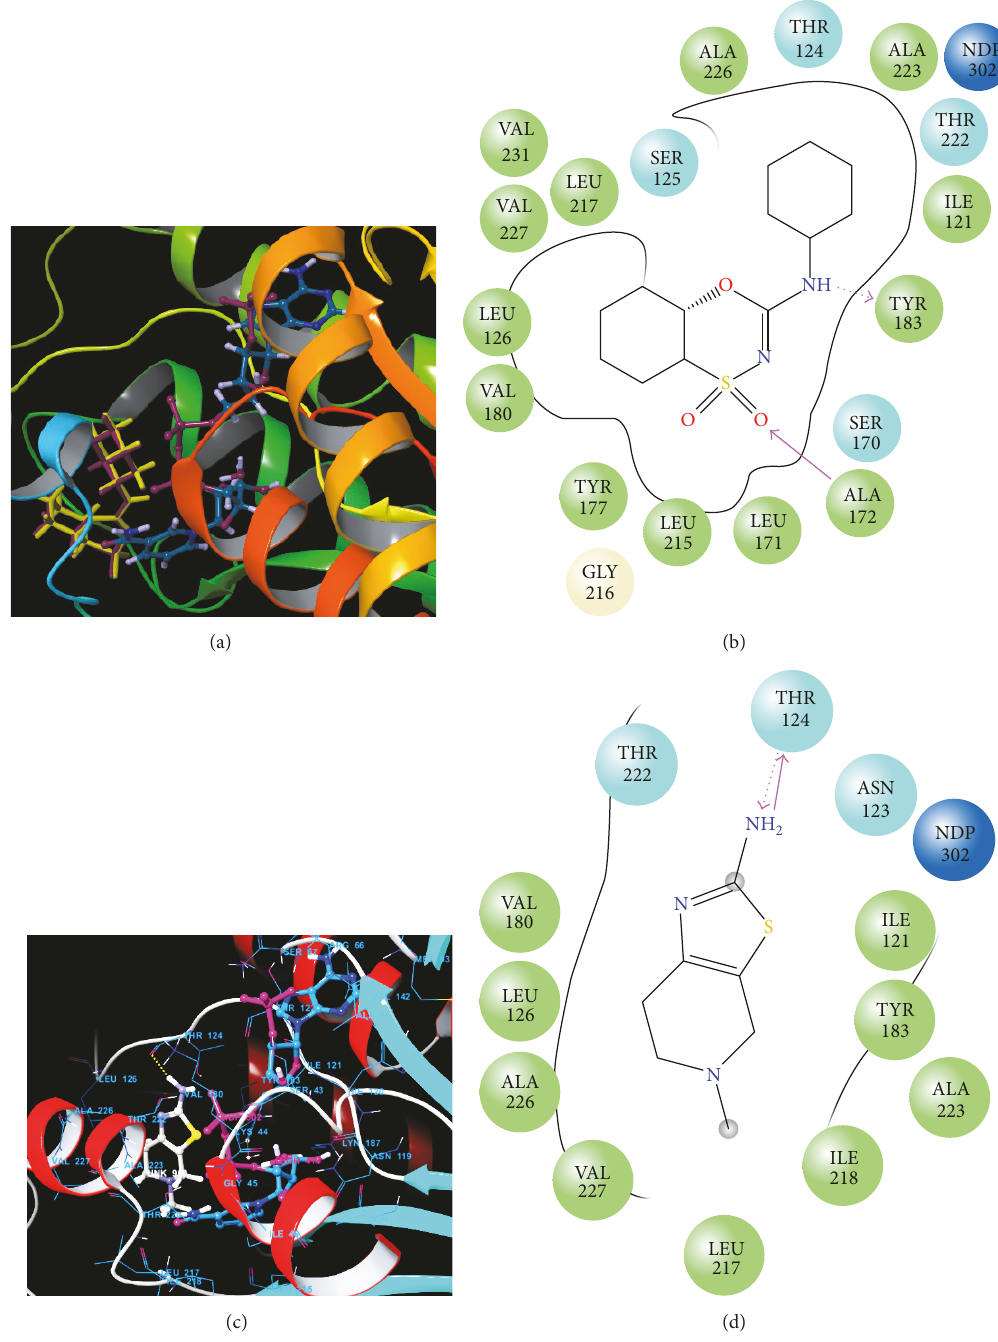
Figure 1: Binding modes of native ligand and TR-04 in the X-ray crystal structure of 11 𝛽 -HSD1 (PDB ID: 4K1L). (a) Superimposition of the poses of cocrystallized native ligand (shown in yellow colored tube representation) with its binding conformation (shown in maroon colored tube representation). (b) The interactions between inbound ligand and amino acid residues of binding pocket (4K1L). (c) The pose of TR- 04 (shown in ball-and-stick representation). (d) The interactions between TR-04 and amino acid residues of binding pocket (4K1L). Green colored circles indicate hydrophobic amino acid residues; blue colored circles indicate polar amino acid